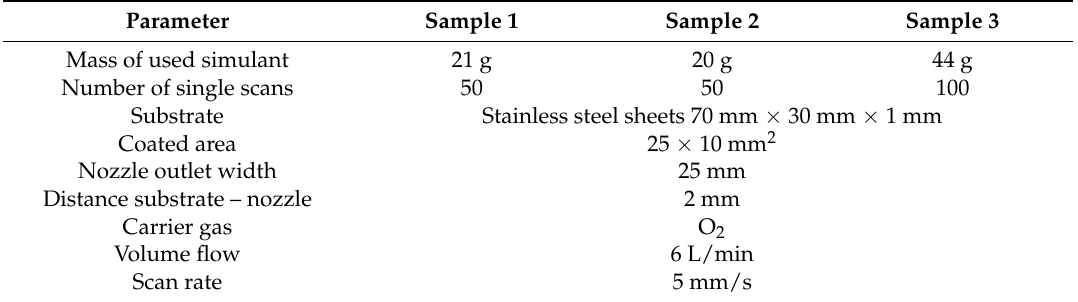
Table 2. Aerosol deposition (AD) system settings for the deposition of